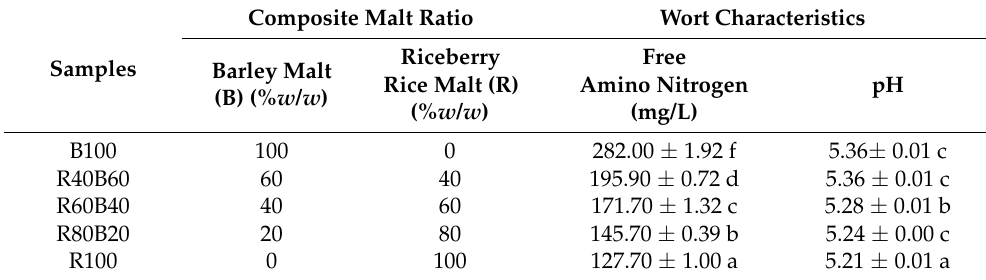
Table 1. Physico-chemical properties of composite malt extract